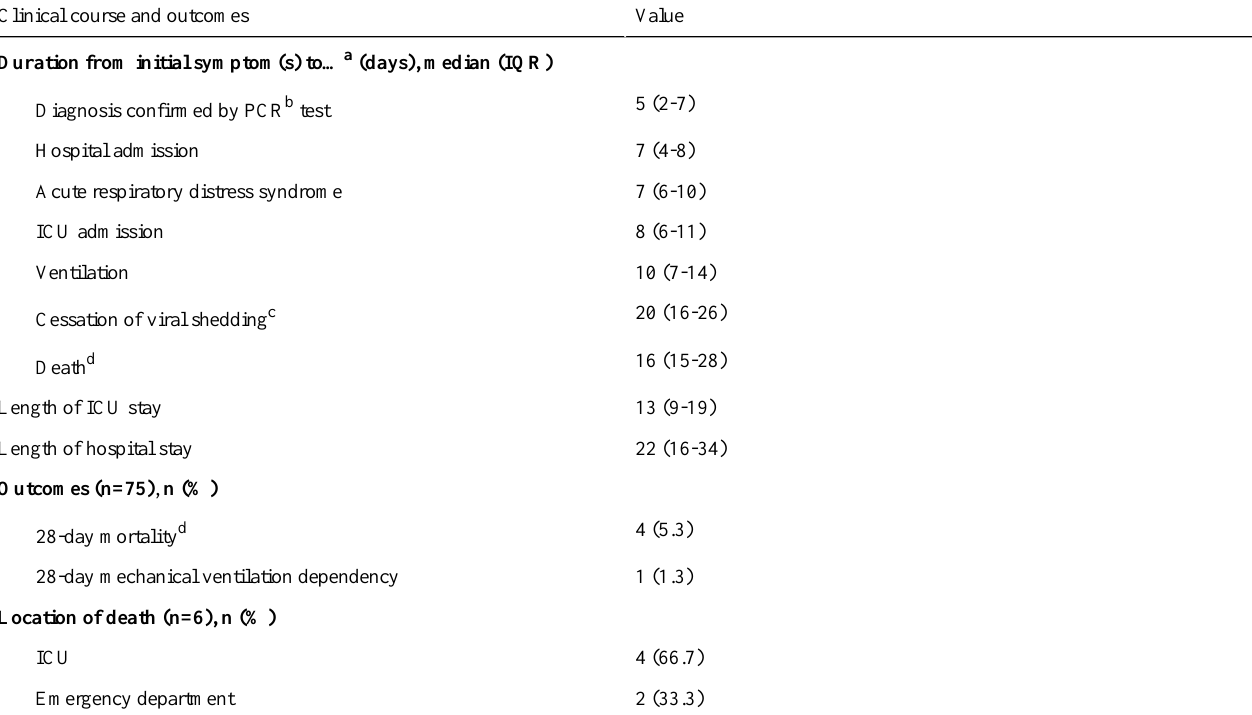
Table 2. Clinical course and outcomes of patients with COVID-19 admitted to the intensive care unit (ICU) in Chongqing, China (from January 21 to March 15, 2020).